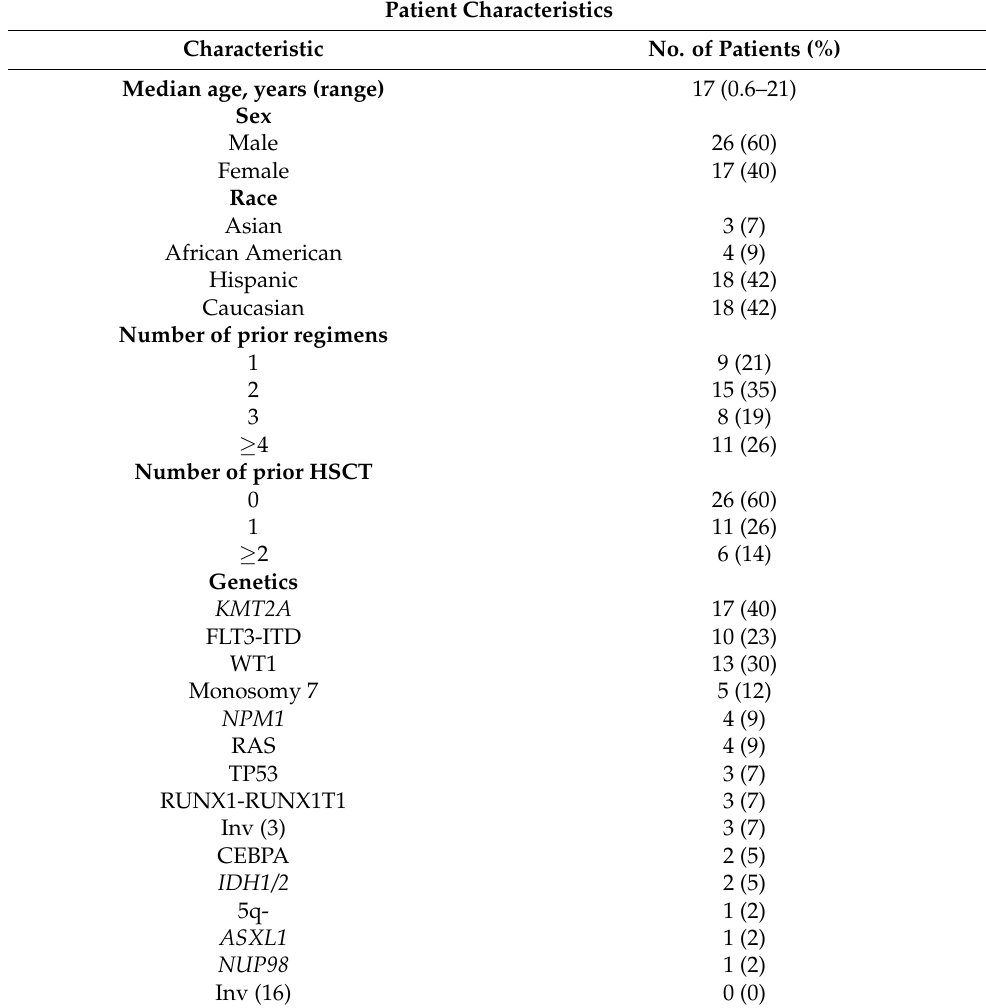
Table 1. Baseline patient demographics and